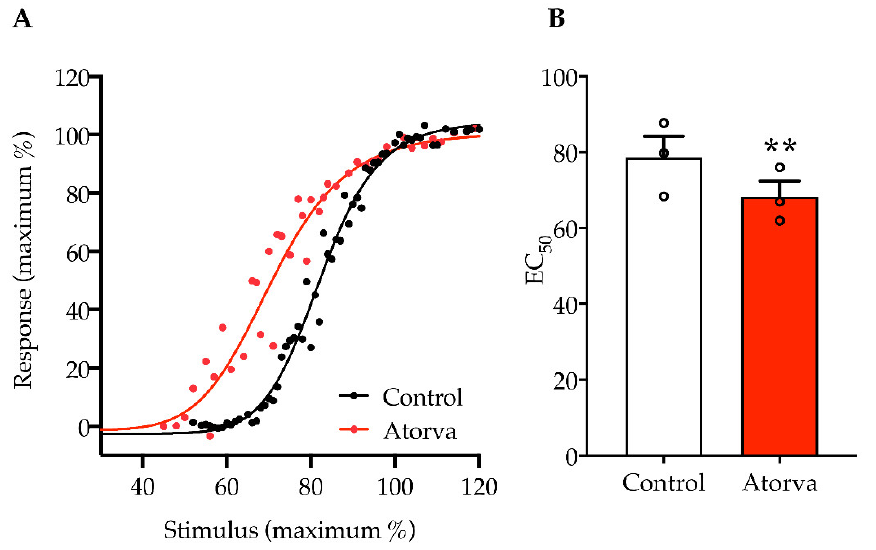
Figure 7. Stimulus-response protocol recordings of C-CAP. Stimulus intensity applied, and C-CAP response measured is presented as the relationship between the fold supramaximal CAP response evoked by crescent current stimuli, normalized on the maximal stimulus applied (expressed in %). Plotted representation of stimulus-response curves ( A ). Stimulus-response curve EC 50 variation has been statistically analysed. Control ( n = 3); Atorva ( n = 3); unpaired t -test, ** p = 0.0031; t = 6.4; df = 4 ( B ). Control = high-fat high-cholesterol diet; Atorva = high-fat high-cholesterol diet plus atorvastatin.